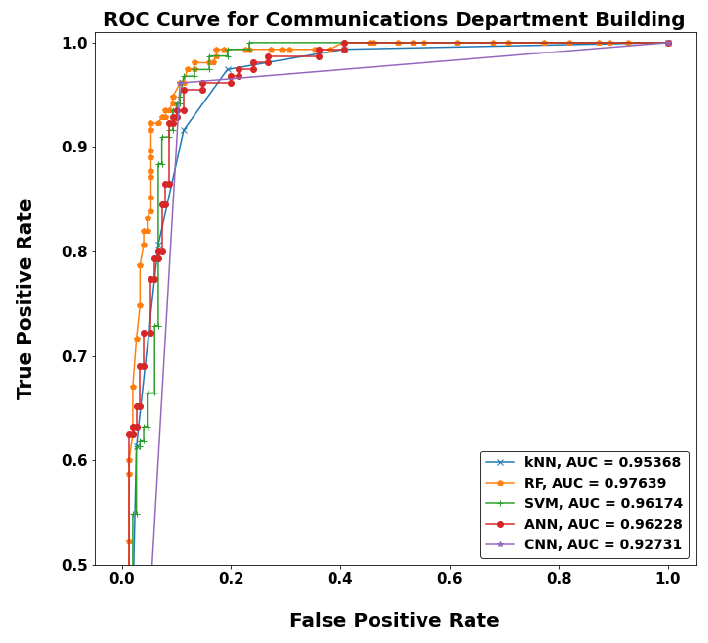
Figure 22. ROC curves for MF-ML models in Communication building.